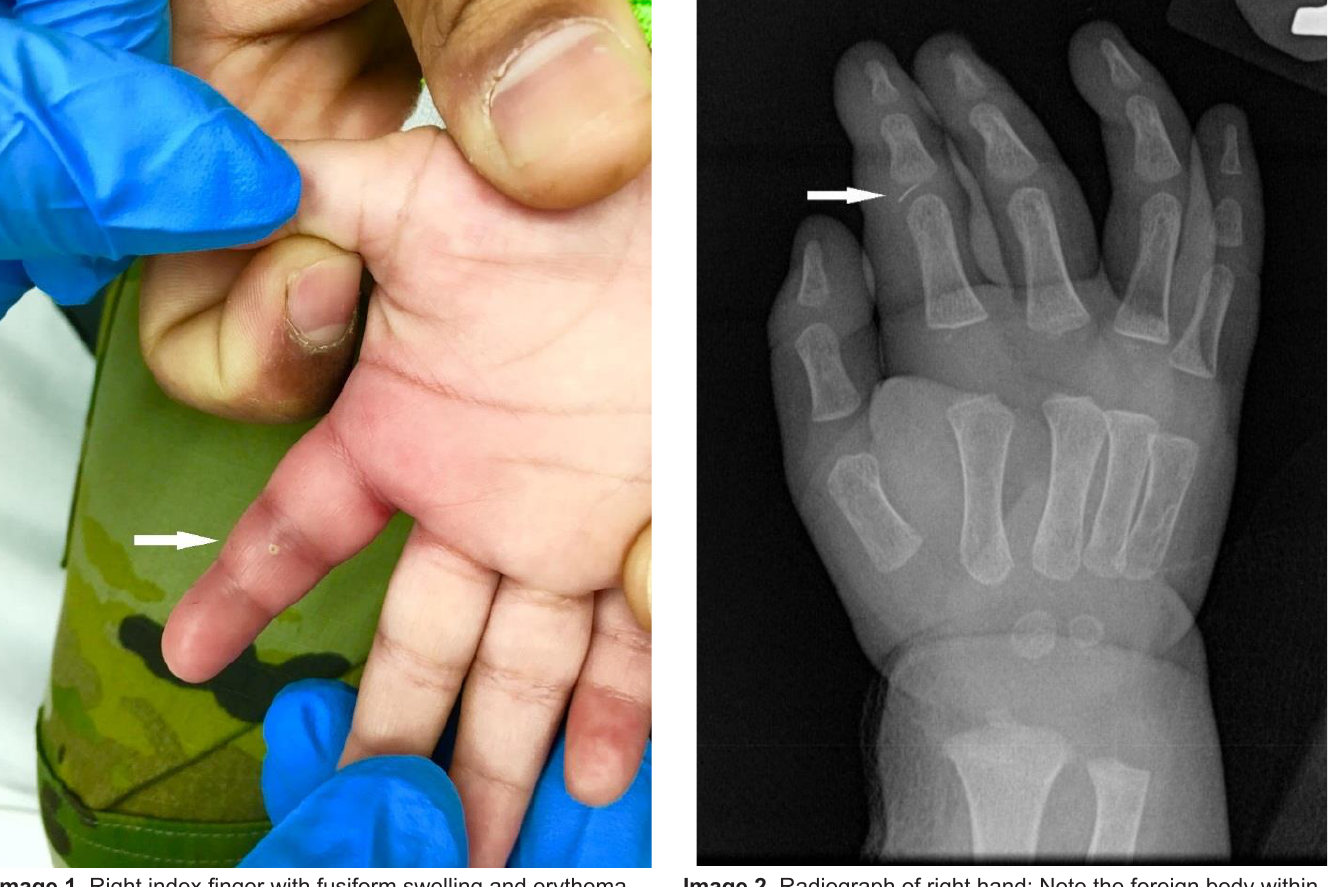
Image 1. Right index finger with fusiform swelling and erythema. Note the pustule over the proximal inter-phalangeal joint (arrow).